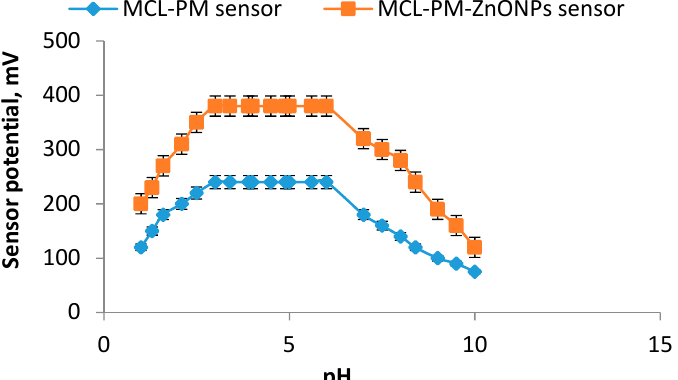
Figure 9. Effect of pH on the constructed conventional and modified ZnONPs-coated wire sensors using 1.0 × 10 − 4 mol L − 1 of MCL solution.